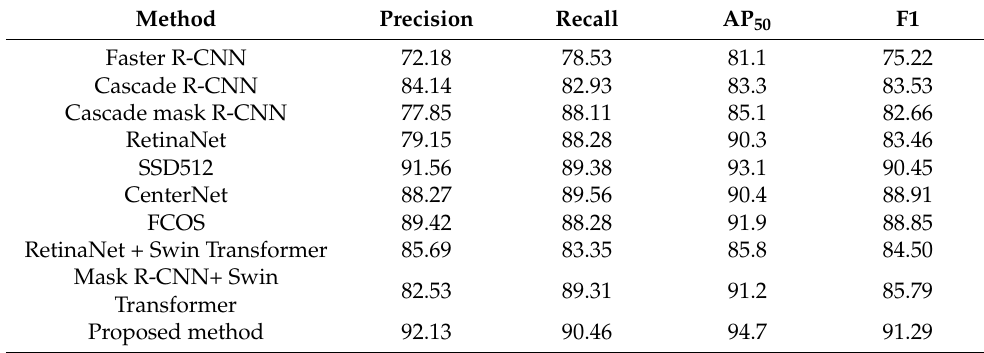
Table 6. Comparison with current object detection methods on the SSDD dataset.